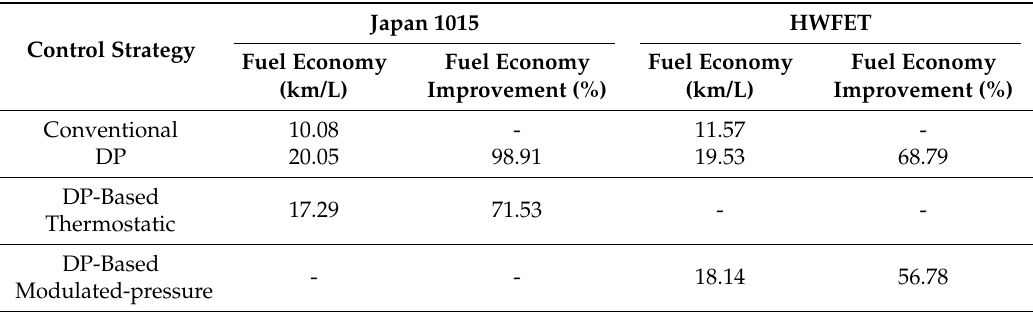
Table 4. Fuel Economy Estimation with Dynamic Programming (DP) and DP-Based Control